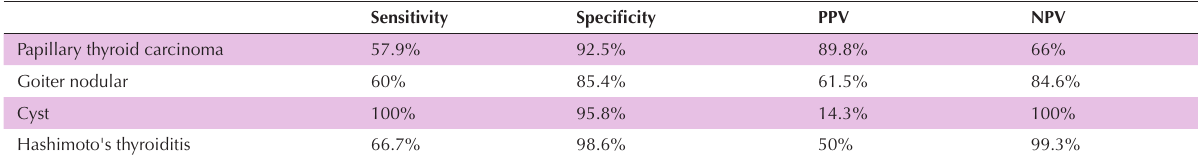
Table 4. Results of the agreement between FNA and surgery for papillary thyroid carcinoma, nodular goiter, cyst and Hashimoto’s